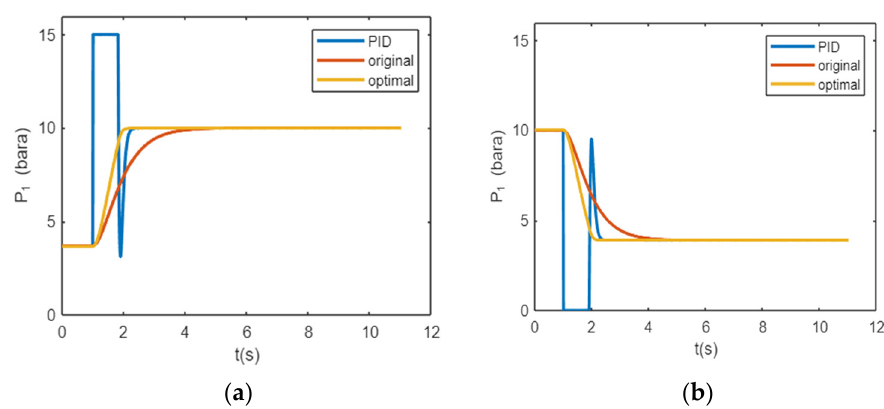
Figure 11. Dynamic pressure response of ejector’s primary inlet with or without PID controller: ( a ) Switching from Ejector A to Ejector B; ( b ) switching from Ejector B to Ejector A. With each ejector controlled by an individual gas ‐ injecting valve, the pressure and mass flow rate were adjusted using PWM control signals. In this work, we compared the maximum pressure fluctuation ( ∆𝑃 (cid:2870) ) caused by shifting the ejectors using only one inlet